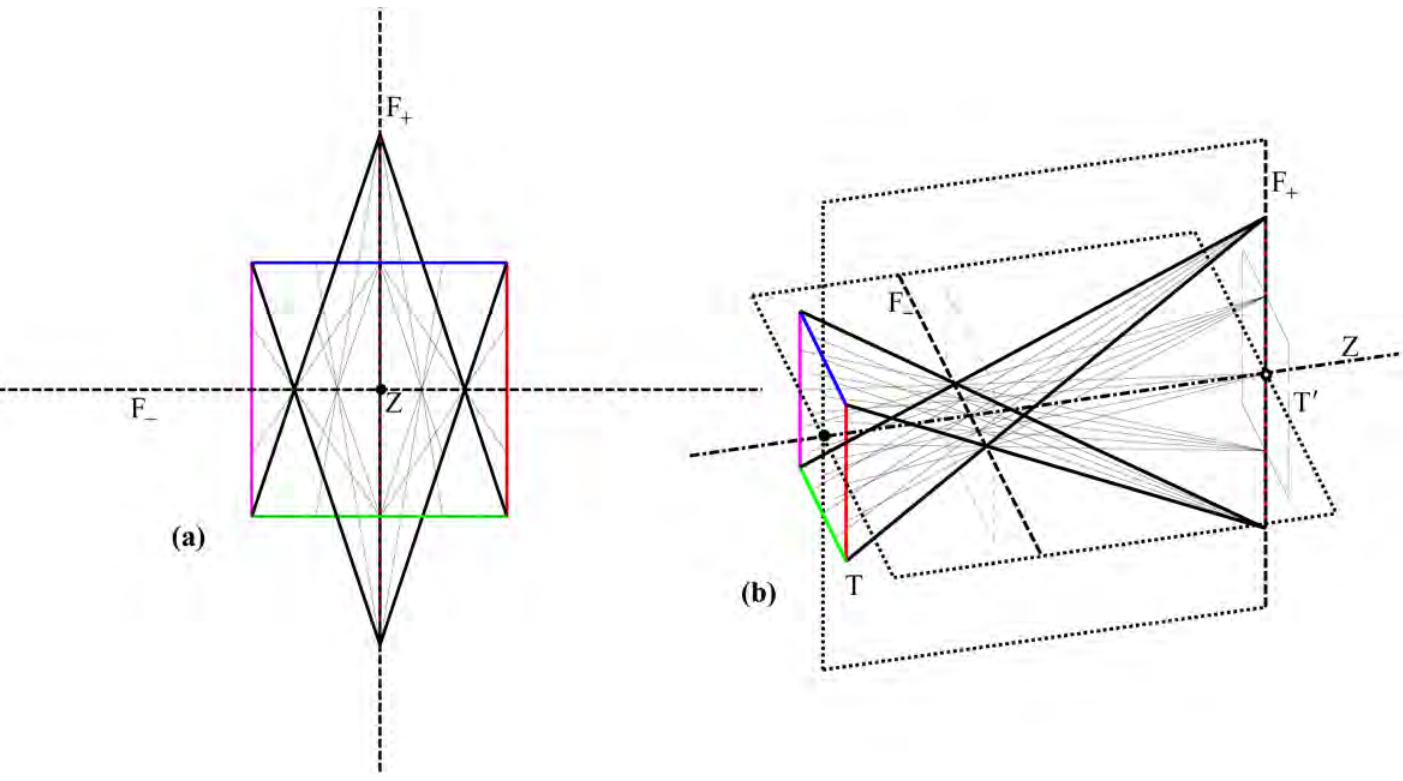
Figure 13 A pencil with divergency 2/ JIM +−= D at T. The pencil is conventional. The second (vertical) focal line is on exit plane T ′ . (b) azimuth °− 20 15 °− 20 , elevation 32 °− 20 .